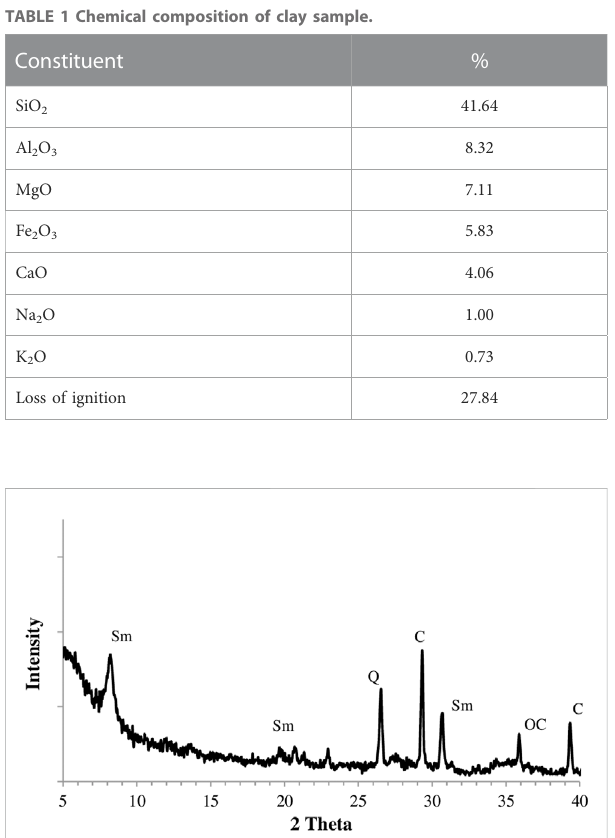
Figure 2 The X-Ray diffractogram of natural clay sample (Sm: Smektit, Q: Quartz, C: Calcite, OC: Opal-C).